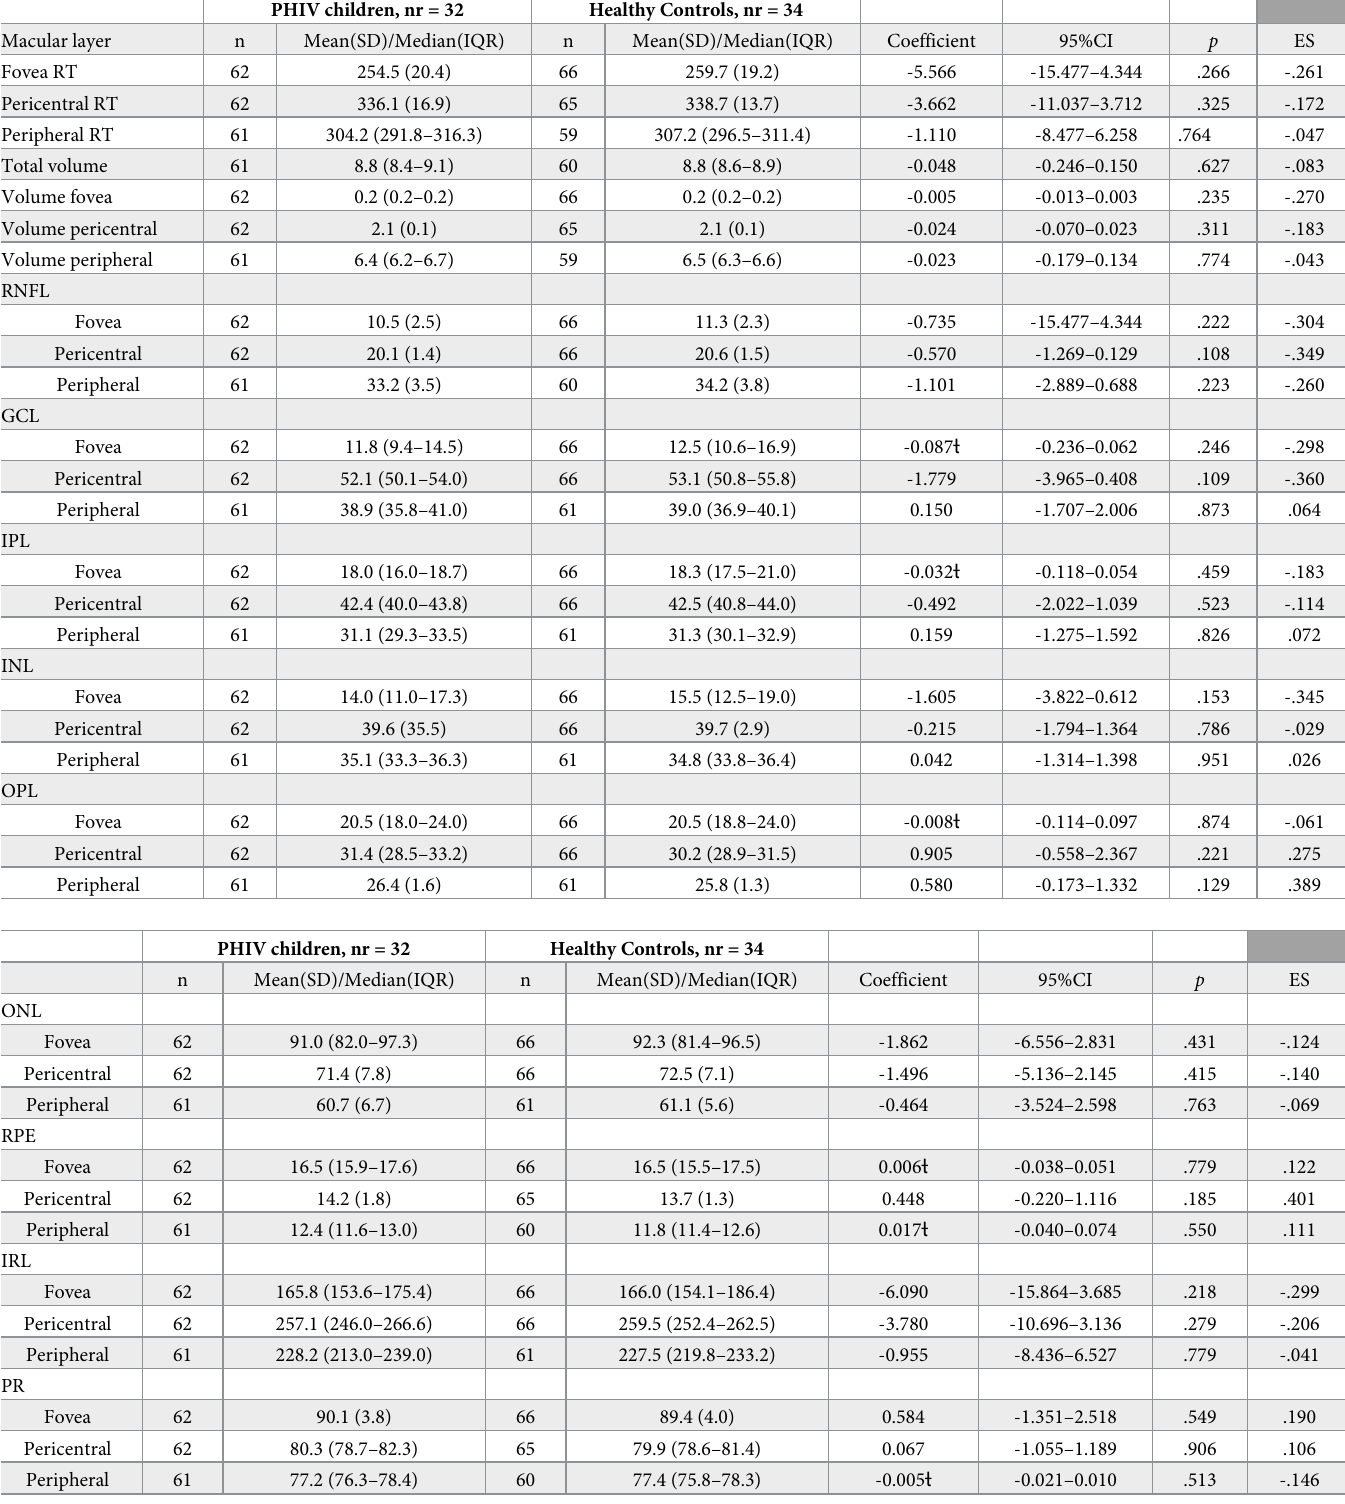
Table 3. OCT individual retina layer thickness in PHIV children and healthy controls, cross-sectional